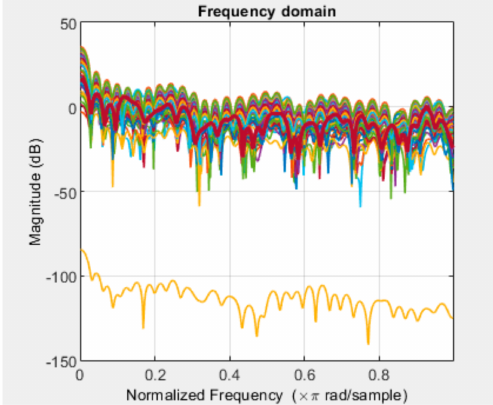
Figure 11. An example of